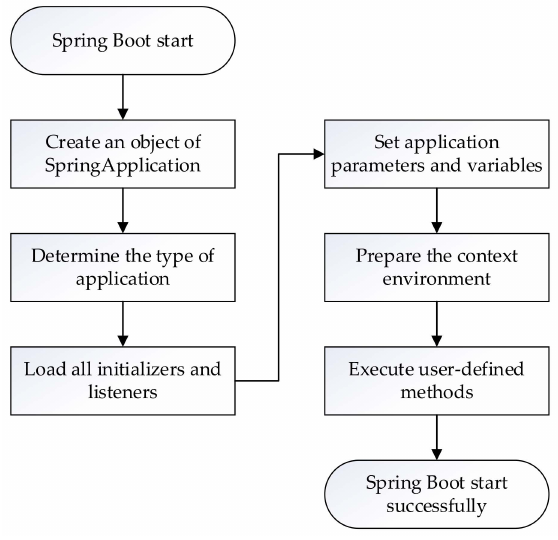
Figure 4. The startup process of the Spring Boot